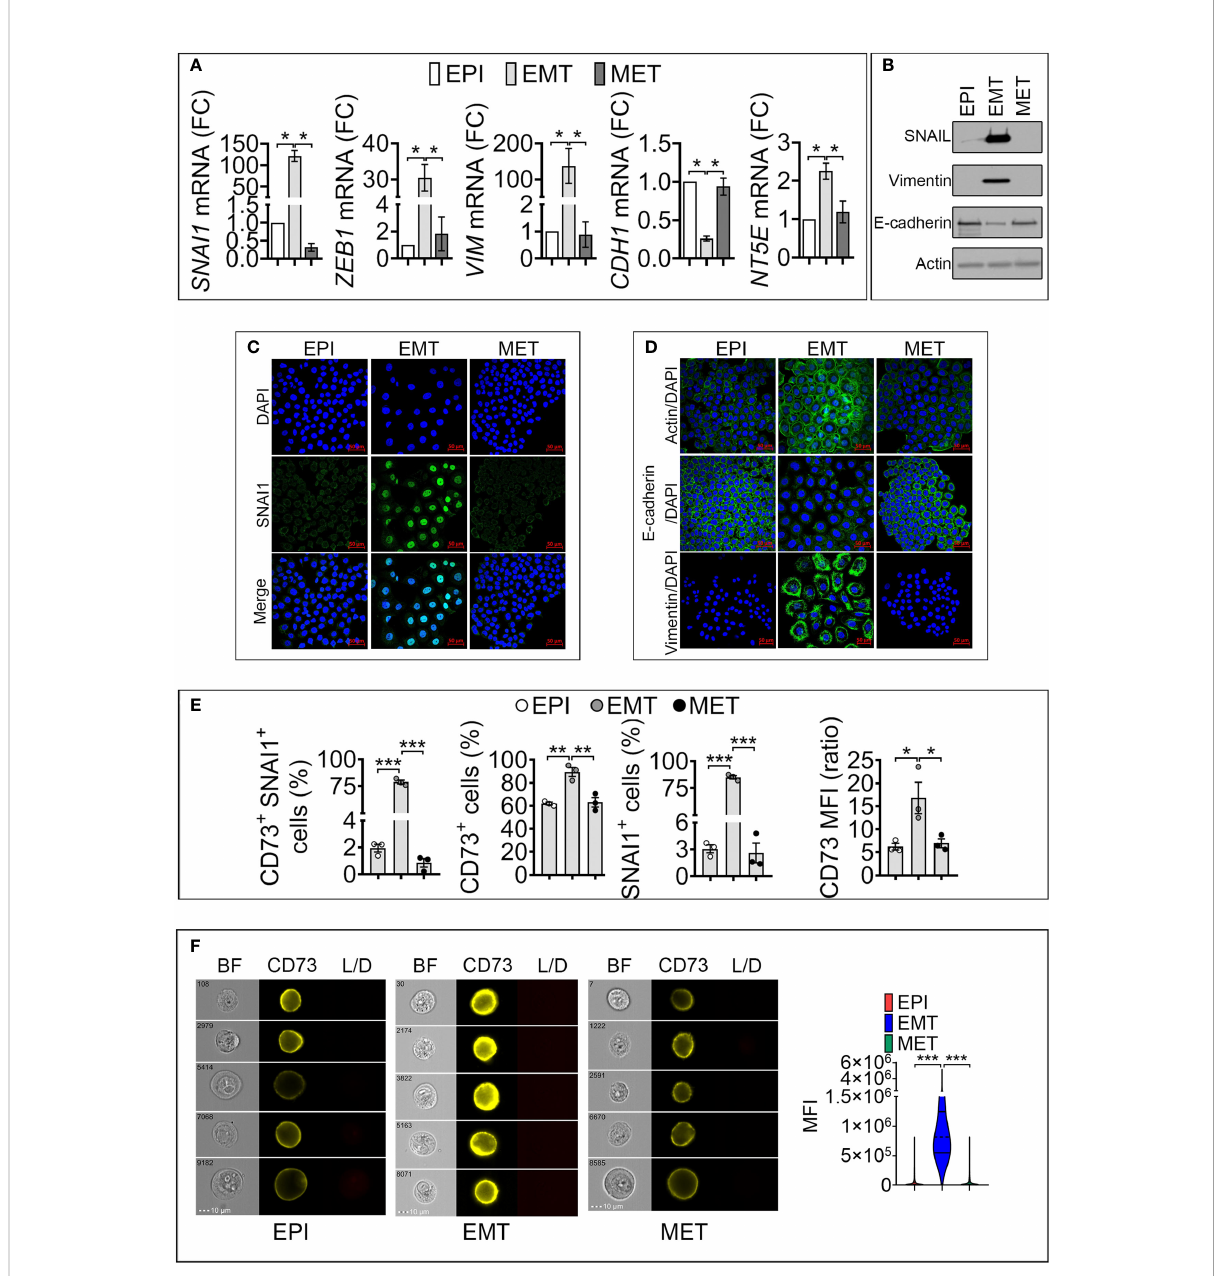
FIGURE 2 Induction of SNAI1 in TNBC MDA-MB-468-iSNAI1 cells upregulates NT5E/CD73 mRNA and protein expression. (A) mRNA expression of SNAI1 , ZEB1, VIM , CDH1 NT5E and NT5E in EPI, EMT, and MET conditions. The expression of each gene in EMT and MET conditions was calculated relative to the EPI condition. Bars represent means from four independent experiments ± SEM (* P < 0.05 calculated by Mann Whitney). (B) Representative Western-blot showing the protein expression of SNAI1, Vimentin, and E-cadherin in MDA-MB-468 cells cultured under EPI, EMT, and MET conditions. Actin was used as a loading control. (C, D) Immuno fl uorescence images of SNAI1 (C) , Actin, E-cadherin, and Vimentin (D) staining (in green) in MDA-MB-468 cells cultured under EPI, EMT, or MET conditions. Nuclei are stained with DAPI (blue). The images shown are representative of two independent experiments. Scale bar: 50 µm. (E) Flow cytometry analysis of the percentage (%) of MDA-MB-468 cells cultured under EPI, EMT, and MET conditions that are positive for both CD73/SNAI1 (CD73+ SNAI1+) and either CD73 (CD73+) or SNAI1 (SNAI1+). CD73 MFI is reported. Bars represent means from three independent experiments ± SEM (*P < 0.05, **P <0.01, ***P < 0.001 by unpaired t-test). (F) CD73 surface expression in MDA-MB-468 cultured under EPI, EMT, and MET conditions by fl ow imaging cytometry. Left panels: representative images of 10 4 acquisitions for each condition on bright fi eld (BF), CD73 and live/dead (L/D) channels. The scale bar and event number are shown. Right panel: Violin plot quanti fi cation of CD73 mean fl uorescence intensity (MFI) in MDA-MB-468. Results are the average of 10 4 events for each condition. (***P < 0.001 calculated by unpaired